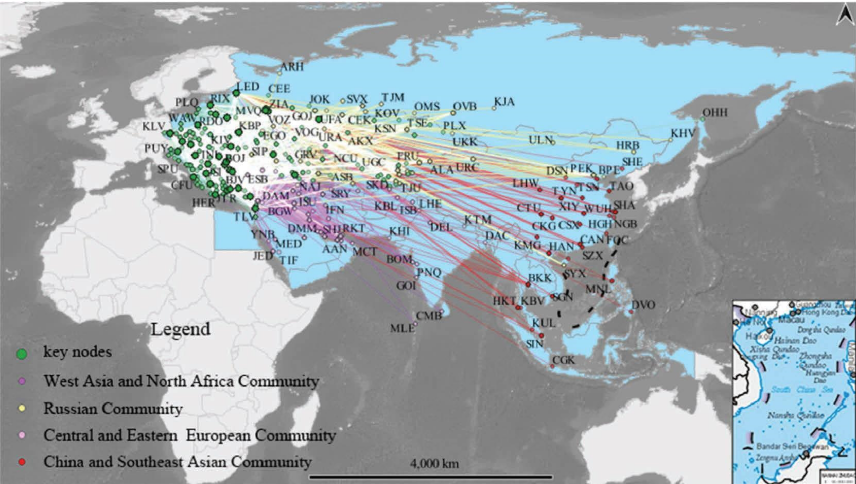
Figure 11: International routes of key node set in Central and Eastern European community.